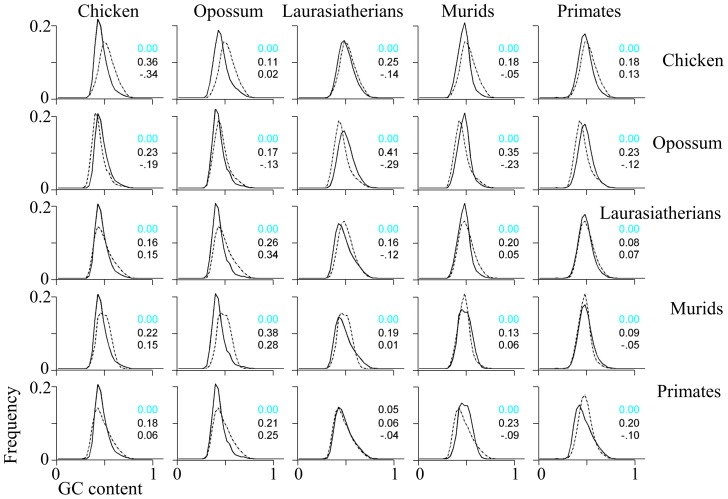
Pairwise comparisons of domain GC content distributions for five taxa.Homogeneous-domain lengths are shown above the diagonal; nonhomogeneous-domain lengths are below, where the distribution curves of the species on the X-axis are solid and those on the Y-axis are dashed. On the diagonal we compare homogeneous and nonhomogeneous domain GC content distributions within a taxon. The first value in each plot is the p-value of significant (Kolmogorov-Smirnov goodness-of-fit test) and the colors represent the actual p-value after correcting for multiple testing using the FDR method (black>0.05 and pink<0.05). The second and third values are effect size calculated as the nonoverlapping percentage of the two distributions and Cohen's d using the Hedges' g estimator, respectively.